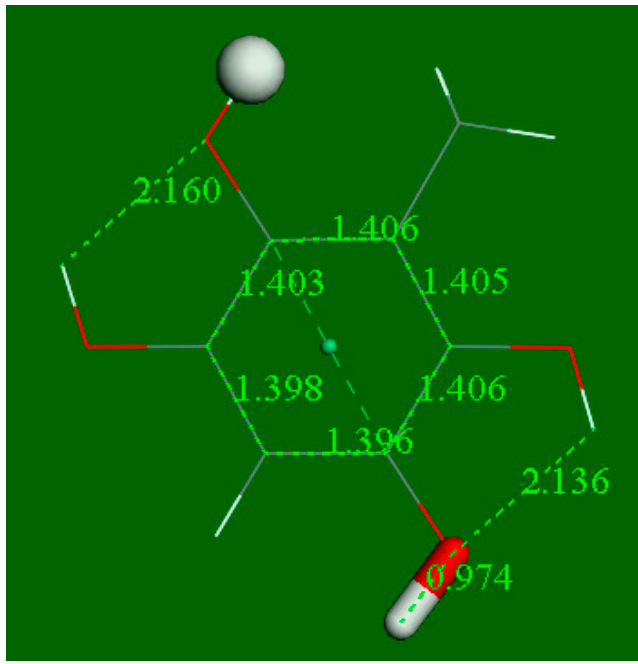
Figure 10. H 2 O was eliminated from the system shown in Figure 9 and a geometry minimization performed.